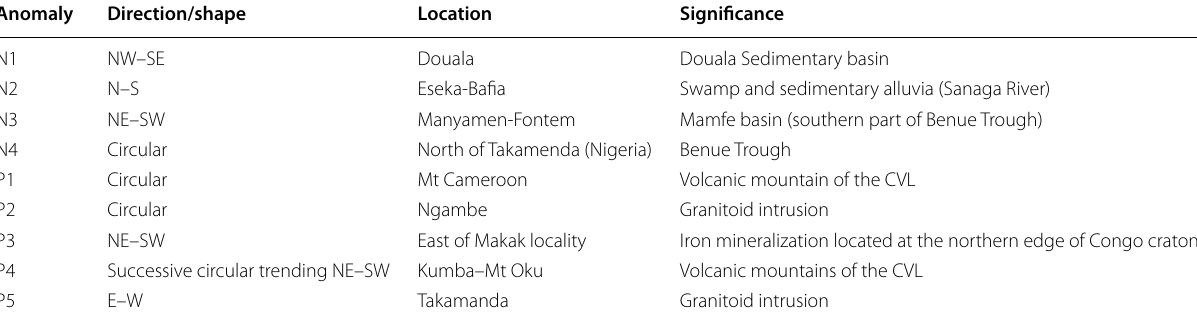
Table 1 Main gravity anomalies of residual